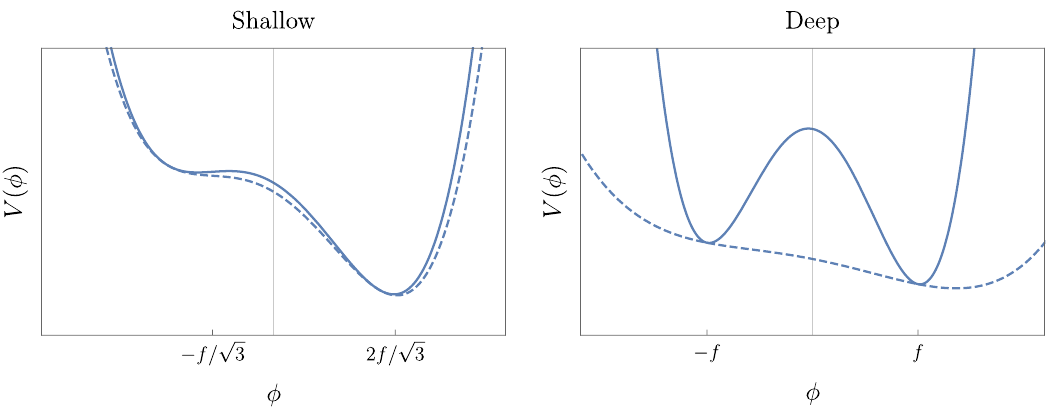
Figure 1: Potentials with shallow (left) and deep (right) minima in vacuum (solid) and in medium for a density n slightly larger than critical